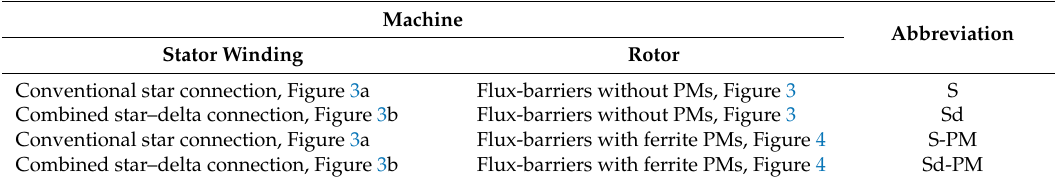
Table 2. SynRM abbreviations.